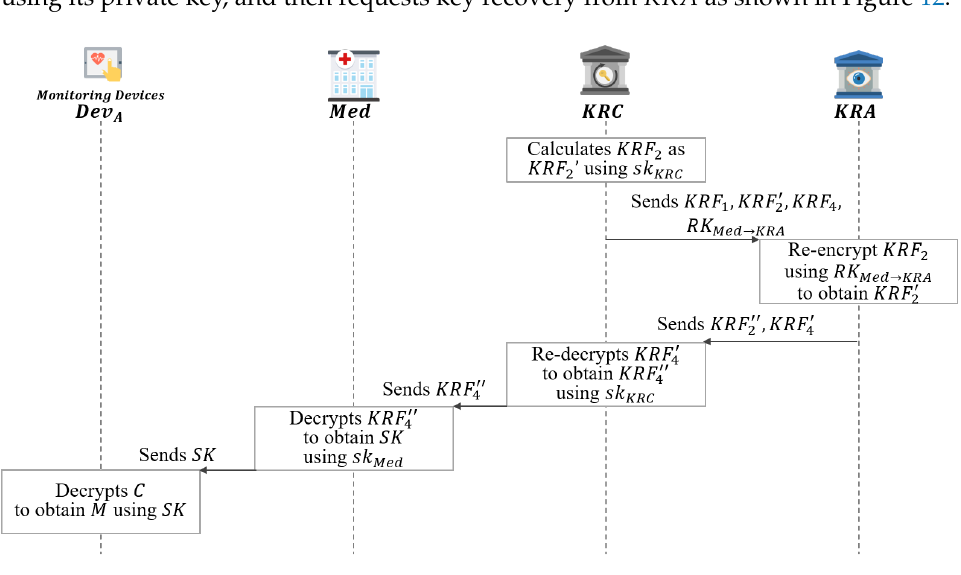
Figure 12. Session key recovery phase of proposed